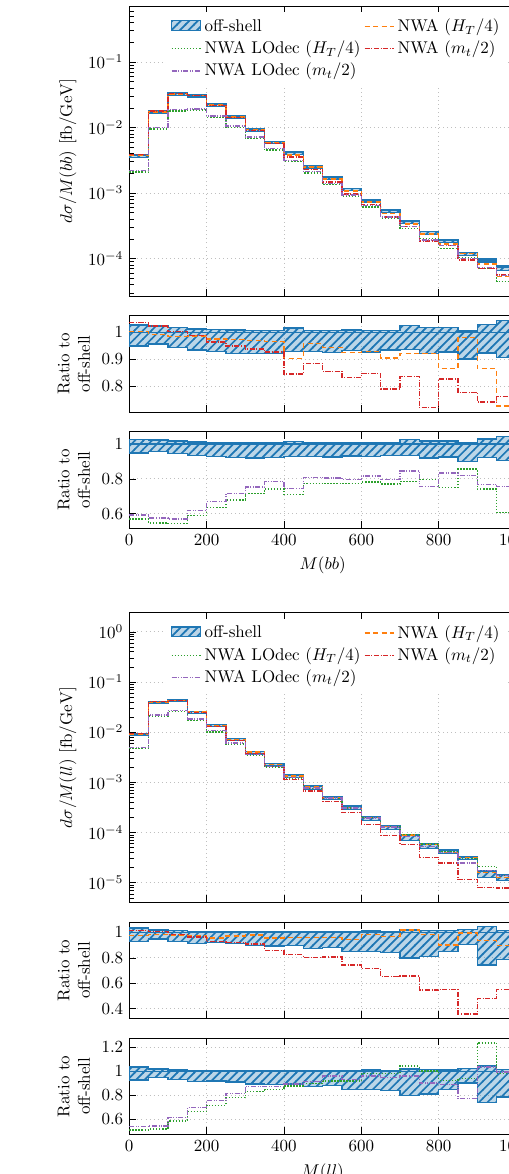
e + (cid:23) e (cid:22) (cid:0) (cid:22) (cid:23) (cid:22) b (cid:22) b(cid:13) process at the !